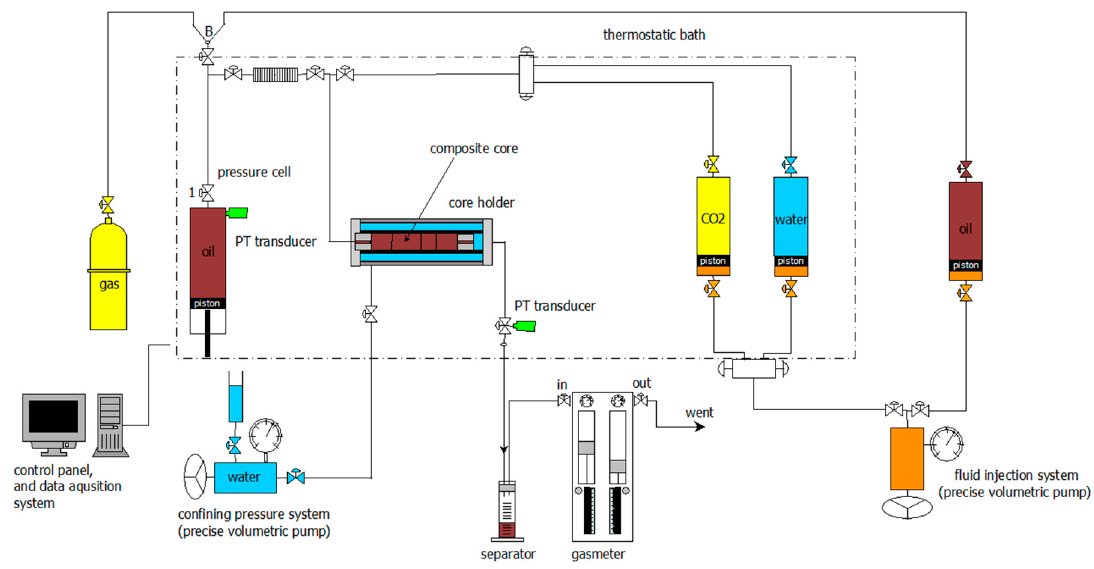
Figure 4. Simplified schematic of the experimental setup.